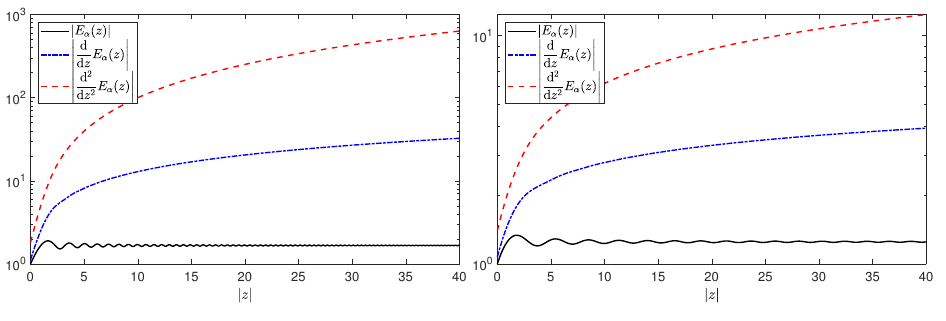
Figure 2. Modulus of E α ( z ) and its first and second derivatives with arg z = απ and α = 0.8 ( right